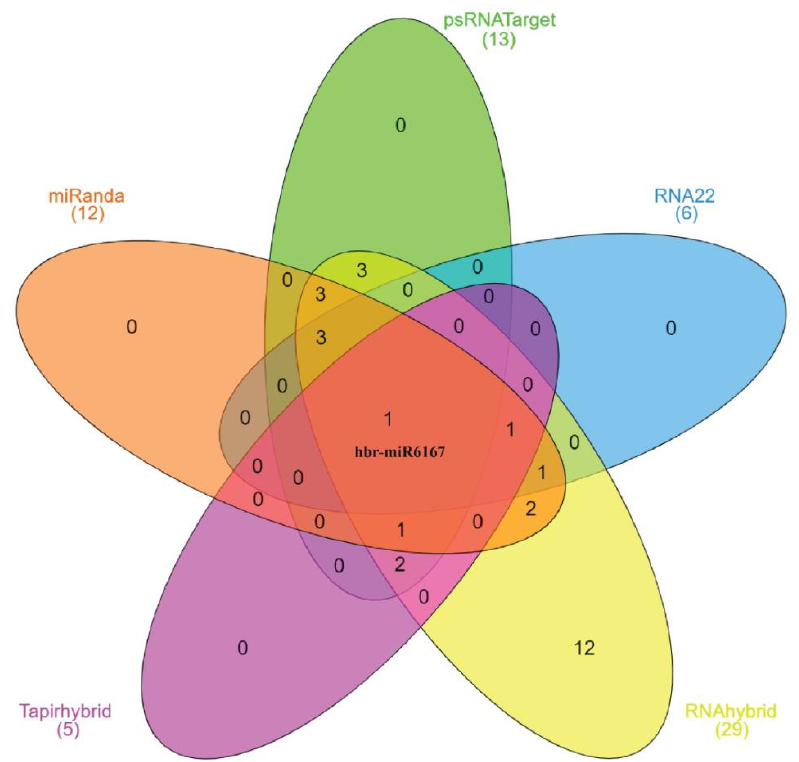
Figure 3. Venn diagram plot of RTV1 representing common rubber tree genome-encoded miRNAs calculated by all the algorithms used in this study. Furthermore, a single rubber tree miRNA (hbr-miR6167) is predicted by all the algorithms used in this study.